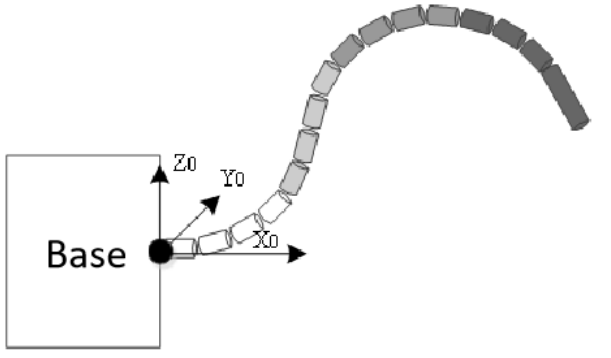
Figure 3. Hyper-redundant flexible